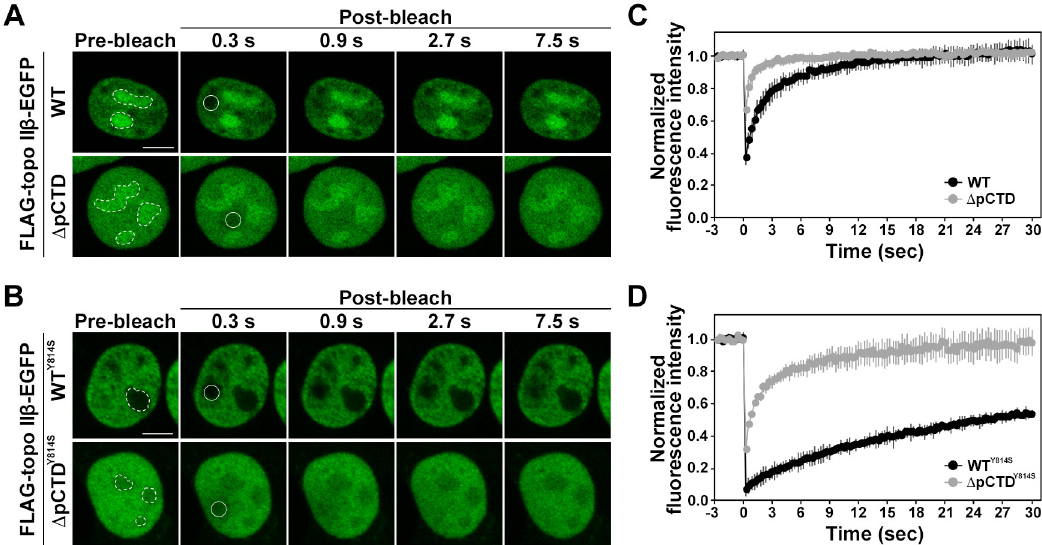
Fig 5. FRAP analysis of FLAG-topo II β -EGFP. (A) Fluorescence recovery kinetics of WT (n = 9) and Δ pCTD (n = 12) in HEK293 cells. The photobleached region is indicated by a circle. Scale bars = 5 μ m. Dotted lines denote nucleoli. (B) Fluorescence recovery kinetics of WT Y814S (n = 5) and Δ pCTR Y814S (n = 6) in HEK293 cells. Dotted lines denote nucleoli. (C, D) Normalized fluorescence intensities are plotted versus time (s). Values represent mean ± S.D.